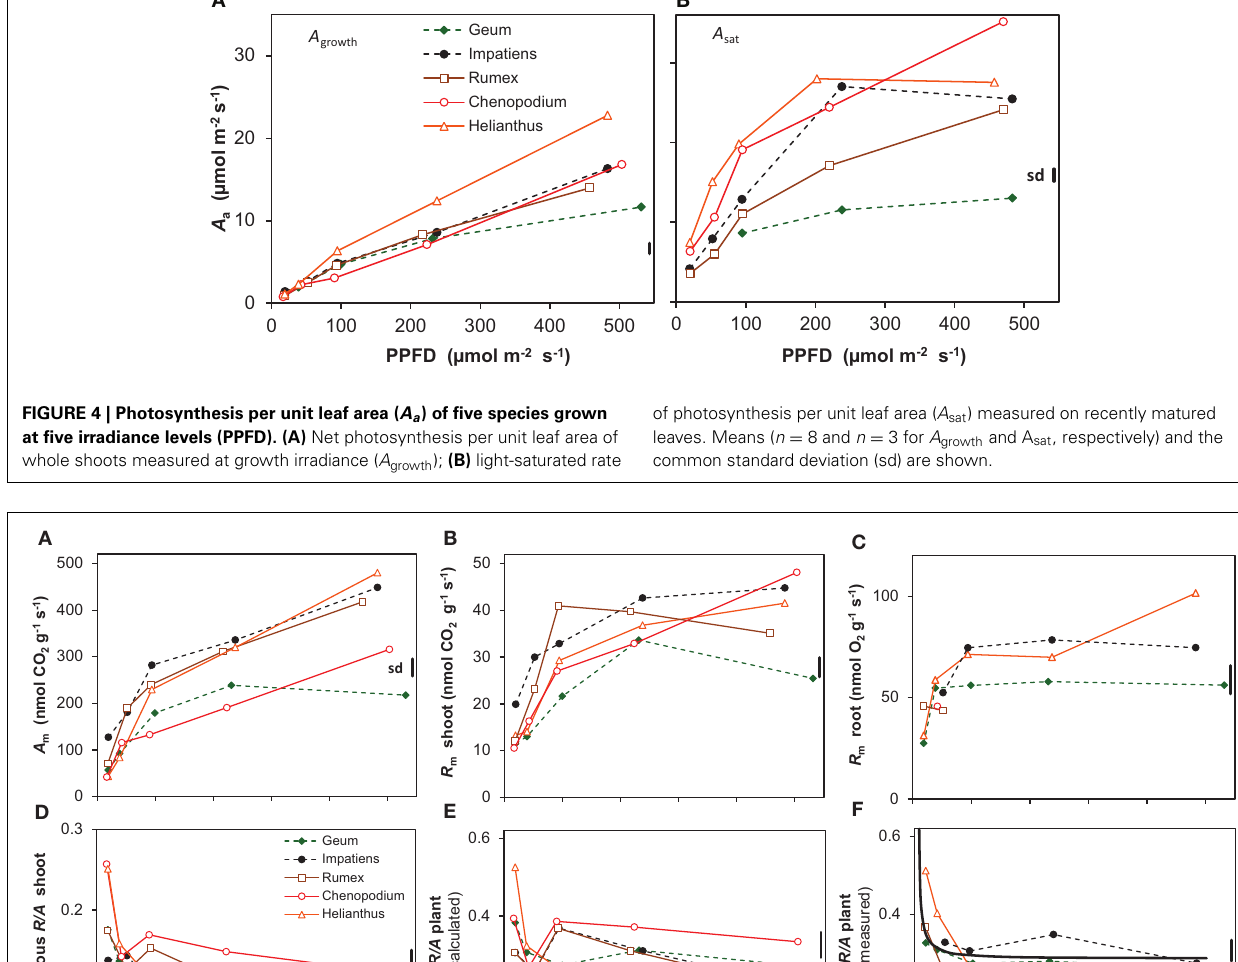
ratio on an instantaneous basis; (E) whole-plant daily R/A ratio using root R calculated from shoot R (root R = 2 . 9 × shoot R ); (F) whole-plant daily R/A ratio based on measured root R for the species and irradiances for which root R was available. Shown are the means ( n = 8) and the average standard deviation (sd). The solid line in (F) depicts the simulated R/A ratio as explained in the